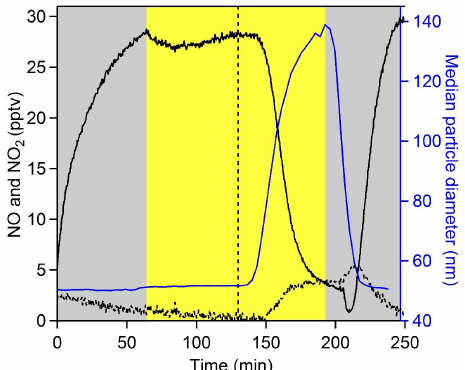
Figure 7. Aerosol flow tube experiments show rapid conversion of NO (solid black line) into NO 2 (dashed black line) only after the time when limonene (gaseous H donor) is added into the flow tube (vertical dashed line). The gray shaded areas represent the experi- ment in the dark, and the yellow shaded area represents the exper- iment under light exposure. The blue line represents the growth of aerosols (right